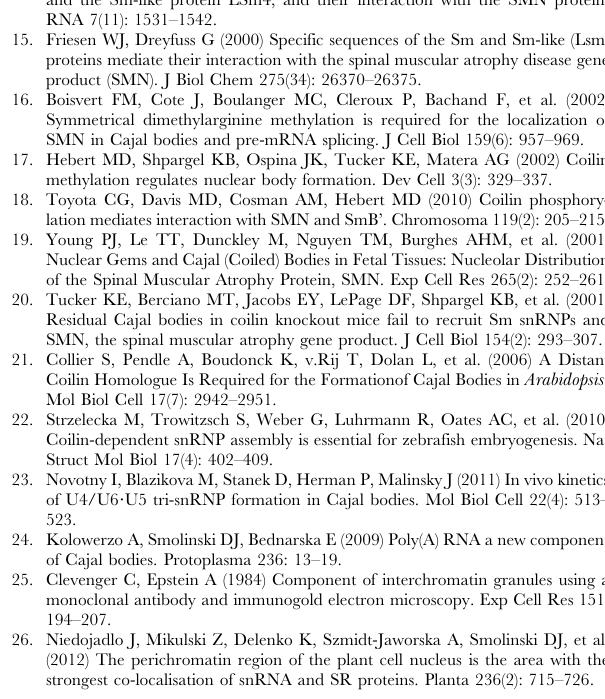
Figure S1 Localisation of poly(A) RNA in protoplasts in lupine root cells: meristematic (A), differentiated (B). Arrows indicate CBs. Double labelling of poly(A) RNA and Sm proteins in: Allium (C-E), Lupinus (F-H) and hypoxia-treated lupin